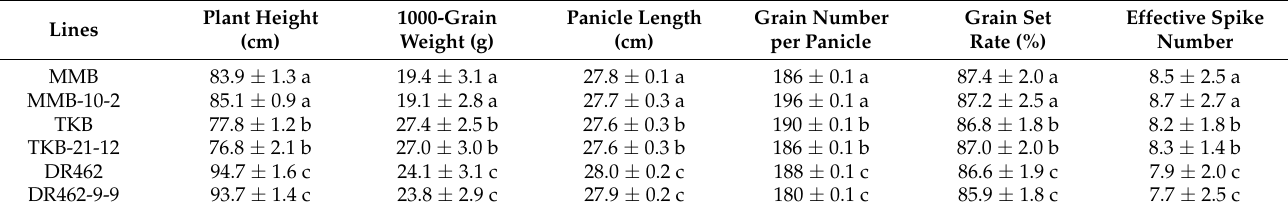
Table 4. Agronomic traits of the mutant lines in the T 2 generation. Lines